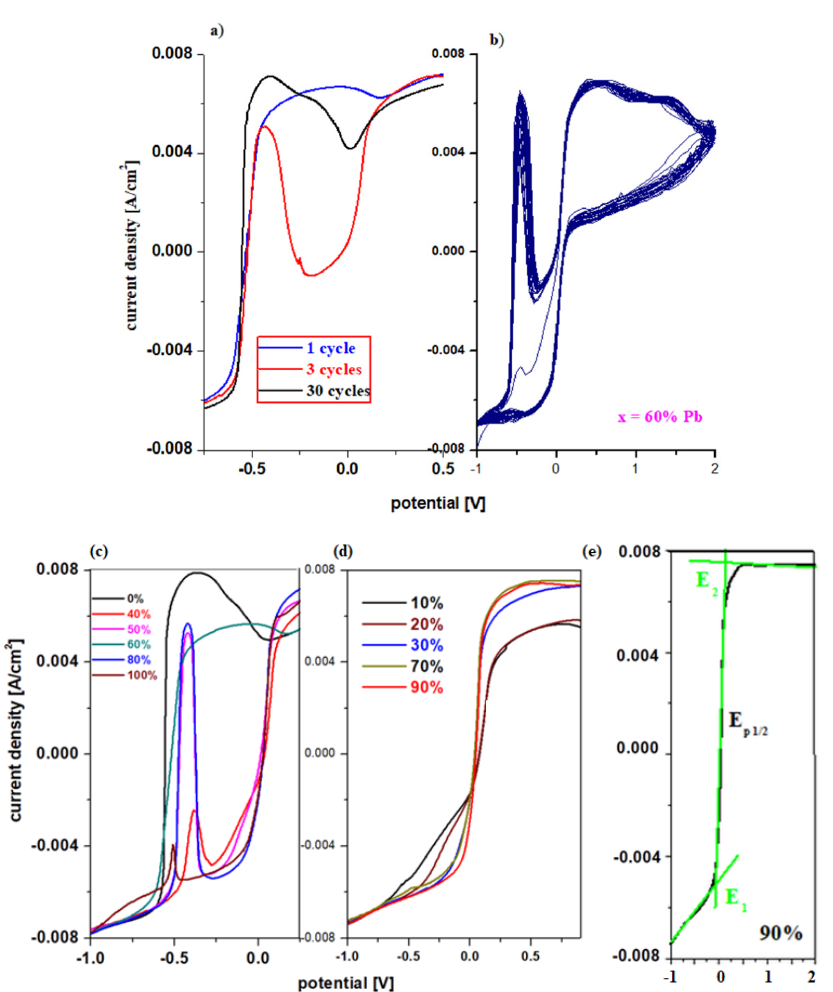
Figure 7. Cyclic voltammograms scanned ( a ) after 1 and 3 cycles and ( b ) after 30 cycles for the vitroceramic system with chemical formula of 15MnO 2 ∙ 85[(100 − x)PbO 2 ∙ xPb] where x = 60 mol% Pb. ( c – e ) Plots of current density versus potential of linear sweep voltammograms for the vitroceramic system with chemical formula of 15MnO 2 ∙ 85[(100 − x)PbO 2 ∙ xPb] where x = 0–100 mol% Pb.